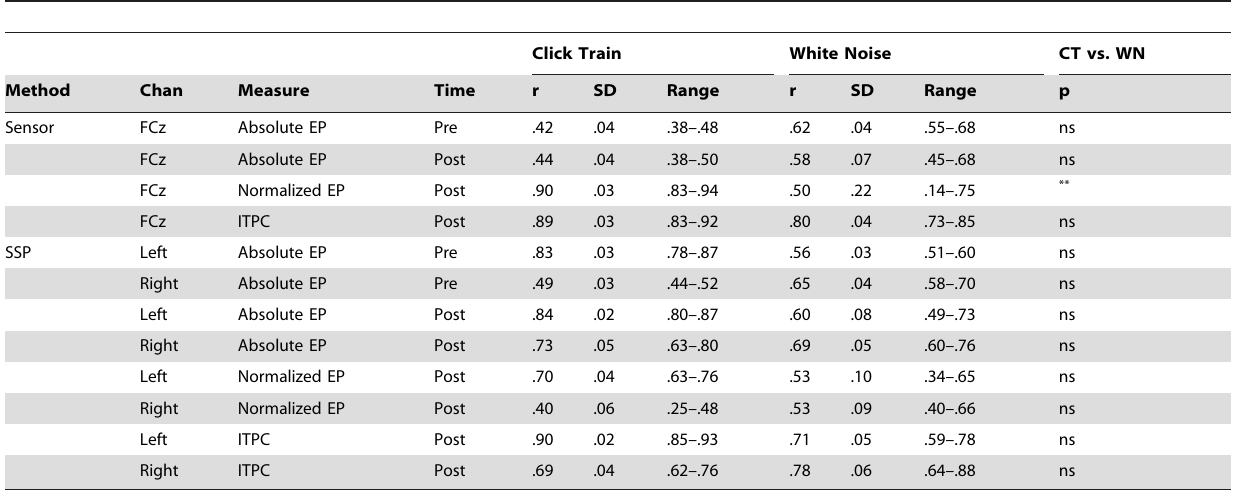
Table 2. Correlation values (Pearson’s r) between sessions 1 and 2 for the auditory steady-state response (40 Hz): time-frequency analyses.